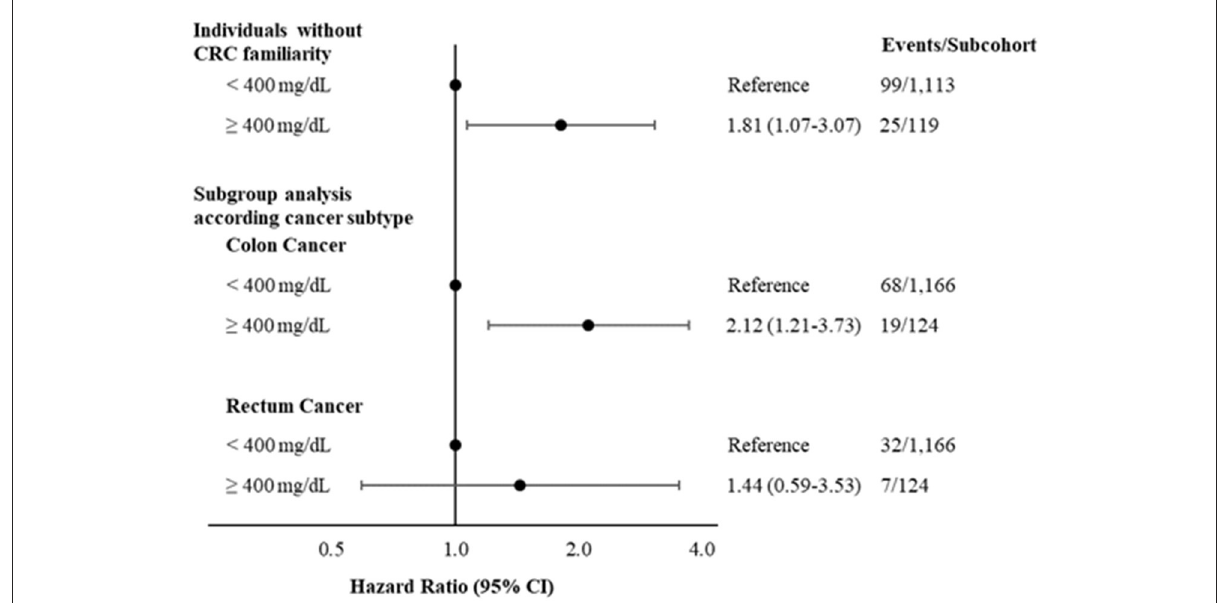
FIGURE2 Hazard ratios and 95% CI, for developing colorectal cancer according to levels of fibrinogen < or ≥ 400 mg/dL excluding individuals with CRC family history and considering different CRC subtypes. Multivariable model adjusted for age, sex, CRC family history (when not stratified by), income, physical activity, diabetes medication and hypercholesterolemia. CRC, colorectal cancer.